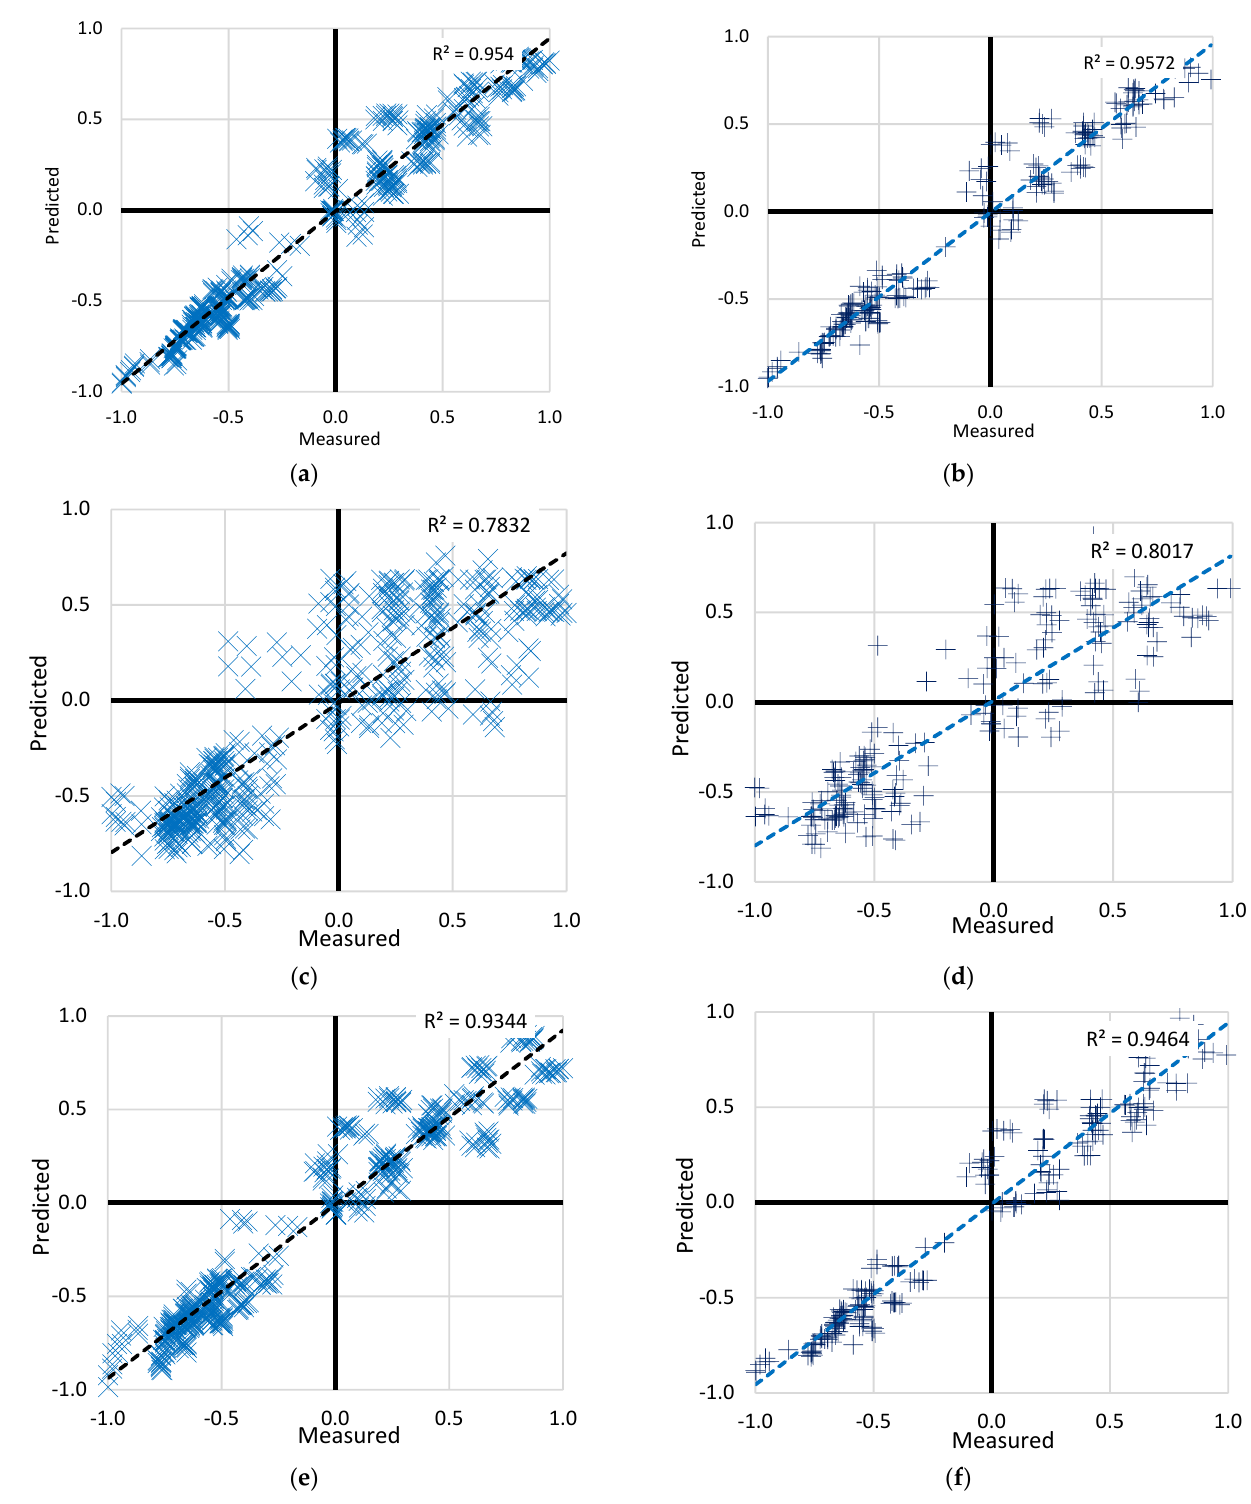
Figure 4. The accuracy of the best-fit proposed model for the ( a ) MVO − MLP training dataset, ( b ) MVO − MLP testing dataset, ( c ) SOSA − MLP training dataset, ( d ) SOSA − MLP testing dataset, ( e ) VSA − MLP training dataset, and ( f ) VSA − MLP testing dataset. The value of R 2 for three methods of MVO, SOSA, and VSA is (0.977 and 0.978), (0.885 and 0.895), and (0.974 and 0.975) for testing and training phases, respectively. Also, in the case of RMSE, MVO, SOSA, and VSA have the value of (0.117 and 0.110), (0.255